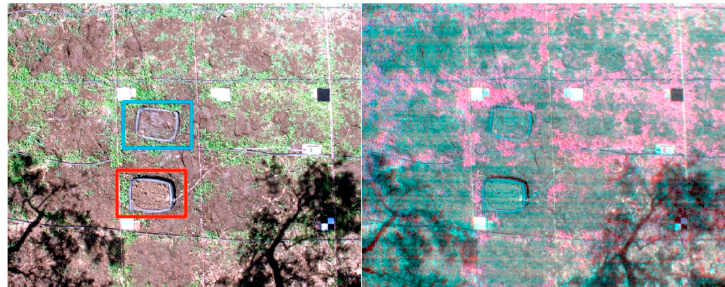
Figure 4. Canon optical image (true color composite, left panel) and Tetracam’s Agricultural Digital Camera (ADC) multispectral image (Color-infrared, CIR, composite, right panel), acquired at 13:21 (solar time) on the 30 July 2013. Wet and dry baskets are highlighted by blue and red boxes respectively (left panel). Vegetation cover is distinguishable by the reddish color (near infrared) in the CIR composite (right panel).